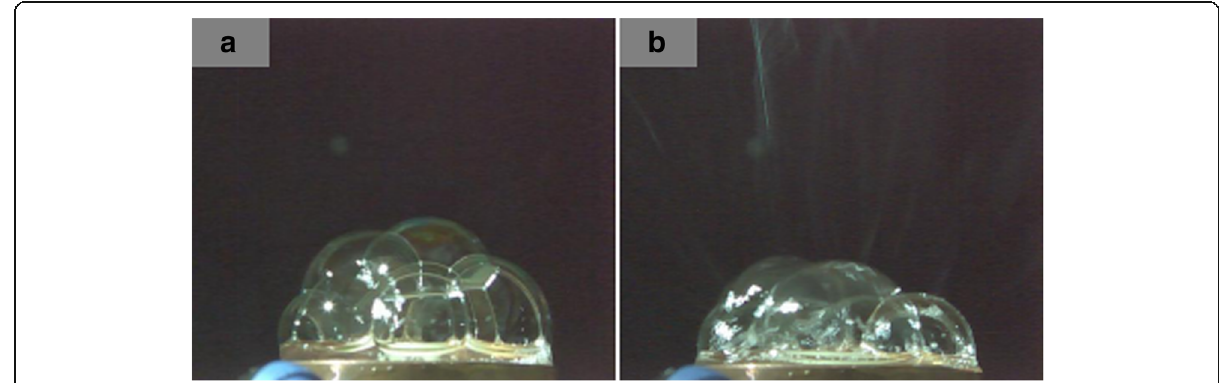
Fig. 3 Photograph of the MFSE with the addition of SDBS. a Photograph of liquid surface and b photograph of spinning